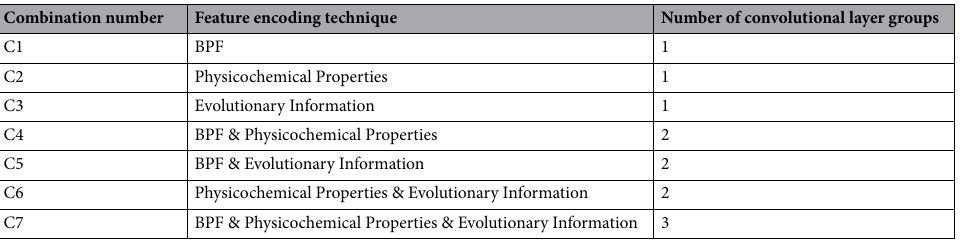
Table 1. Summary of seven combinations of the three sequence representations explored in this study. On the First column of the table, we present the name of the combination, on the second column we present the name of the representations used to build the given combination, and in the third column we present the number of convolutional groups for the given combination.